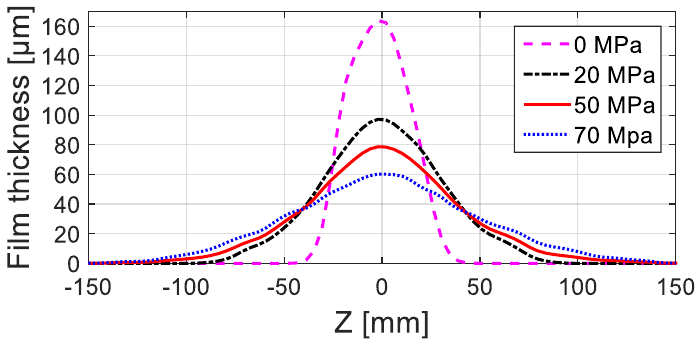
Figure 8. Comparison of coating film thickness distribution along Z for four shaping air pressures: 0, 0.02, 0.05, 0.07 MPa. Table 3. Coating film thickness distribution for four shaping air pressures.